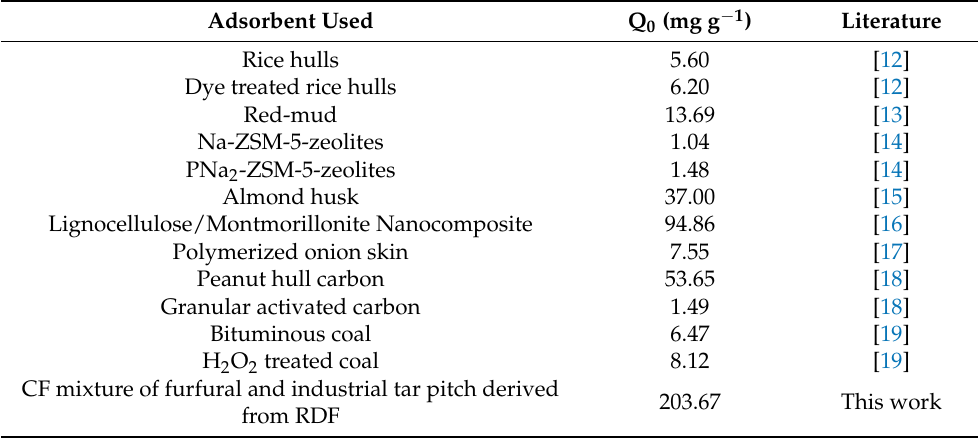
Table 3. Adsorption activity towards Ni (II) of different adsorbents.